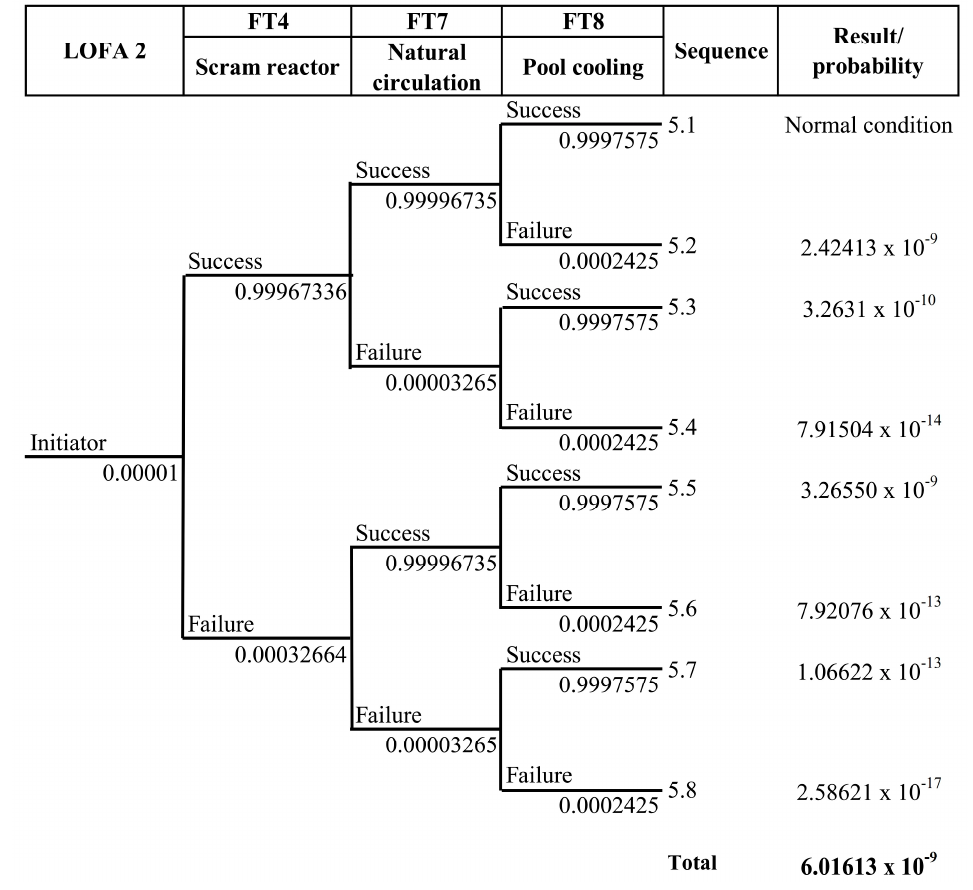
Figure 14. Event tree of LOFA 2.